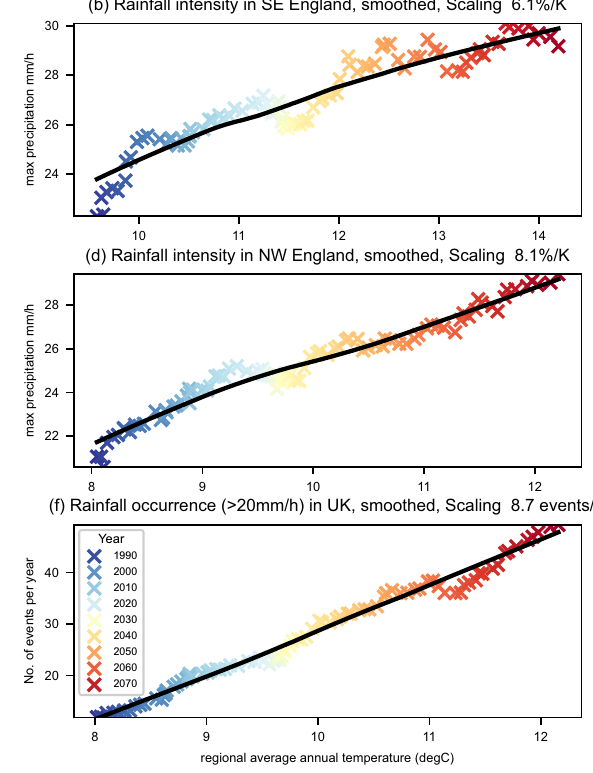
Fig. 5 | Temperature scaling of intensity and occurrence of extreme hourly precipitation. The highest annual maximum hourly 12km precipitation (mm/h) across grid points is plotted against the regional average annual temperature (°C) per year, for a , b South-East England and c , d North-West England, in the convection-permittingmodel(CPM).Alsoshownis e , f numberofeventsexceeding 20mm/h across the UK per year plotted against UK average annual temperature.